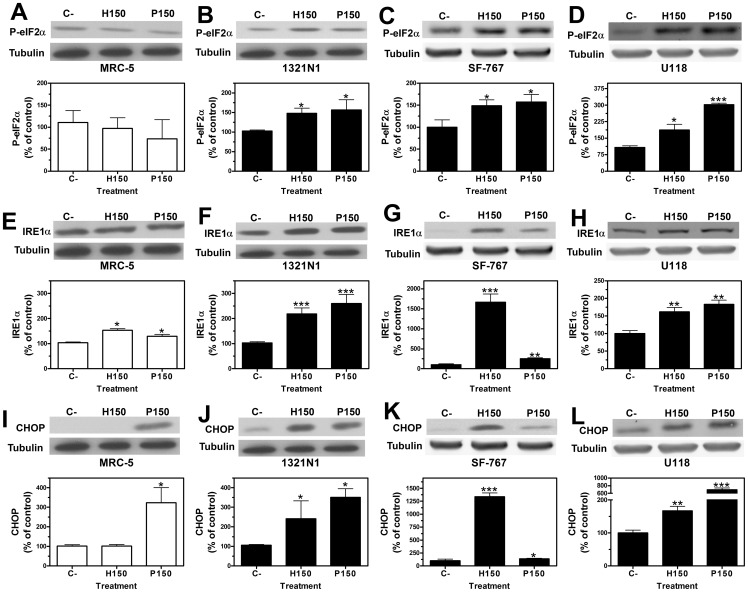
2OHOA activation of ER stress/UPR signaling pathways in 1321N1, SF-767 and U118 but not in MRC-5 cells.P-eIF2α, IRE1α and CHOP protein levels in 1321N1, SF-767 and U118 human glioma cells and in non-cancer MRC-5 human fibroblast cells determined by immunoblotting. Upper panels: a representative immunoblot showing P-eIF2α, IRE1α or CHOP and Tubulin levels in each cell line after exposure to 2OHOA (H) or palmitate (P: 150 µM). Lower panels: Bar diagram showing the mean±SEM P-eIF2α, IRE1α or CHOP expression in each cell line after exposure to 2OHOA (H) or palmitate (P) (150 µM) compared to untreated controls (C). A. P-eIF2α expression in MRC-5 cell line B. P-eIF2α expression in 1321N1 cell line C. P-eIF2α expression in SF-767 cell line D. P-eIF2α expression in U118 cell line after exposure to 2OHOA (H) or palmitate (P) (150 µM; 12 h). E. IRE1α expression in MRC-5 cell line F. IRE1α expression in 1321N1 cell line G. IRE1α expression in SF-767 cell line H. IRE1α expression in U118 cell line after exposure to 2OHOA (H) or palmitate (P) (150 µM; 48 h). I. CHOP expression in MRC-5 cell line J. CHOP expression in 1321N1 cell line K. CHOP expression in SF-767 cell line L. CHOP expression in U118 cell line after exposure to 2OHOA (H) or palmitate (P) (150 µM; 48 h) (*p<0.05, **p<0.01, ***p<0.001; n = 6).